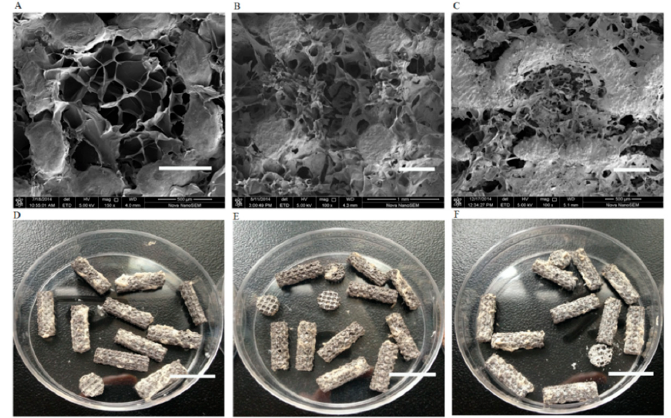
Figure 2. Surface characterization and gross view of hybrid scaffolds by scanning electron micrograph (SEM). Gel:nHA = 1:0 group ( A , D ); Gel:nHA = 1:1 group ( B , E ); Gel:nHA = 1:3 group ( C , F ). Scale bar: 500 μ m ( A – C ), 15 mm ( D – F ).